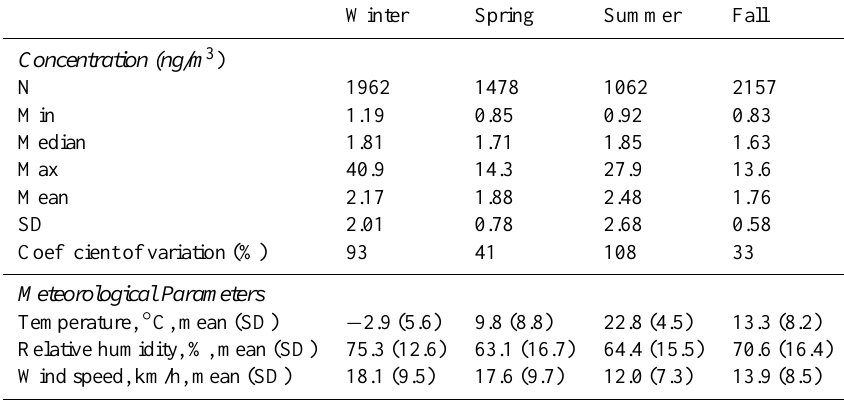
Table 1. Statistical summary of seasonal analysis of hourly TGM concentrations and meteorological parameters in Windsor in 2007. Winter Spring